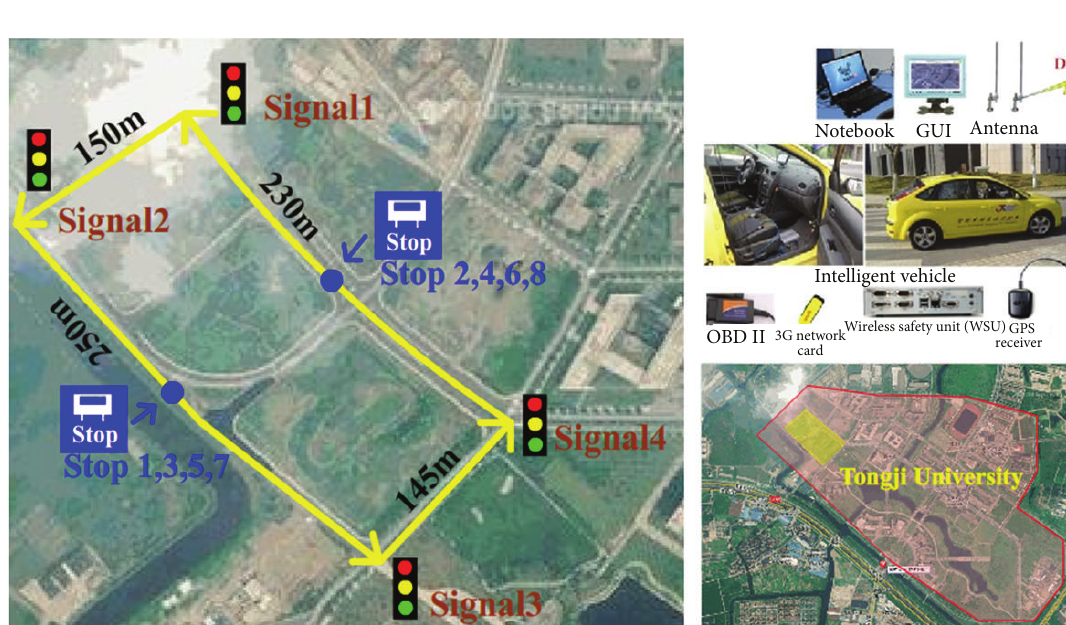
Figure 5: HIL simulator interface.